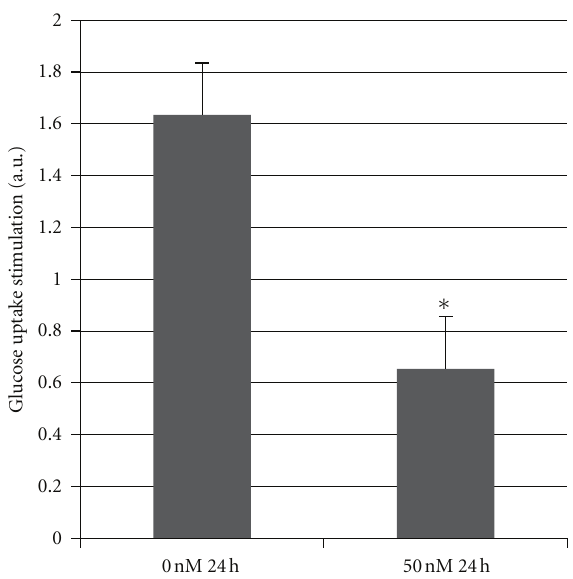
Figure 2: C2C12 cells were di ff erentiated from myoblasts to myotubes as described in Section 2. Myotubes were transfected at each concentration of siRNA (SI00906220) (0 and 50nM) at the designated time point (24h). Cells were then stimulated with insulin (100nM, 30 min), and a 2-DOG uptake was performed ( ∗ P < 0 . 05). Data is reported as the glucose uptake stimulation which is expressed as the ratio of dpm/ μ g of total protein in presence of insulin to that in the absence of